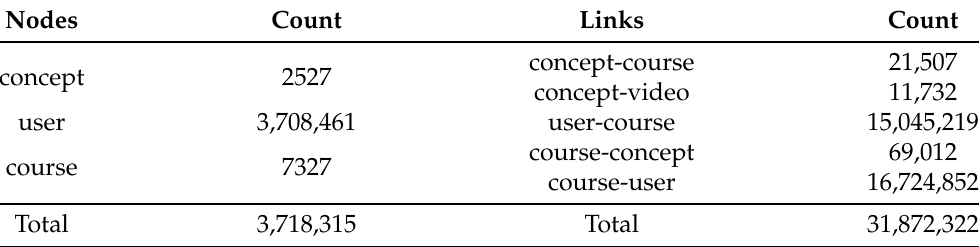
Table 2. An overview of XuetangX MOOCs